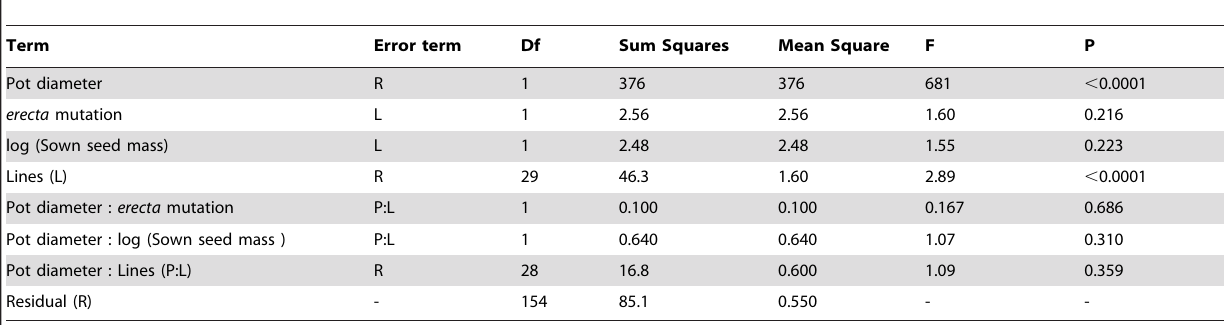
Table 4. ANOVA of the total mass of seeds with sown seed mass fitted as an explanatory variable.